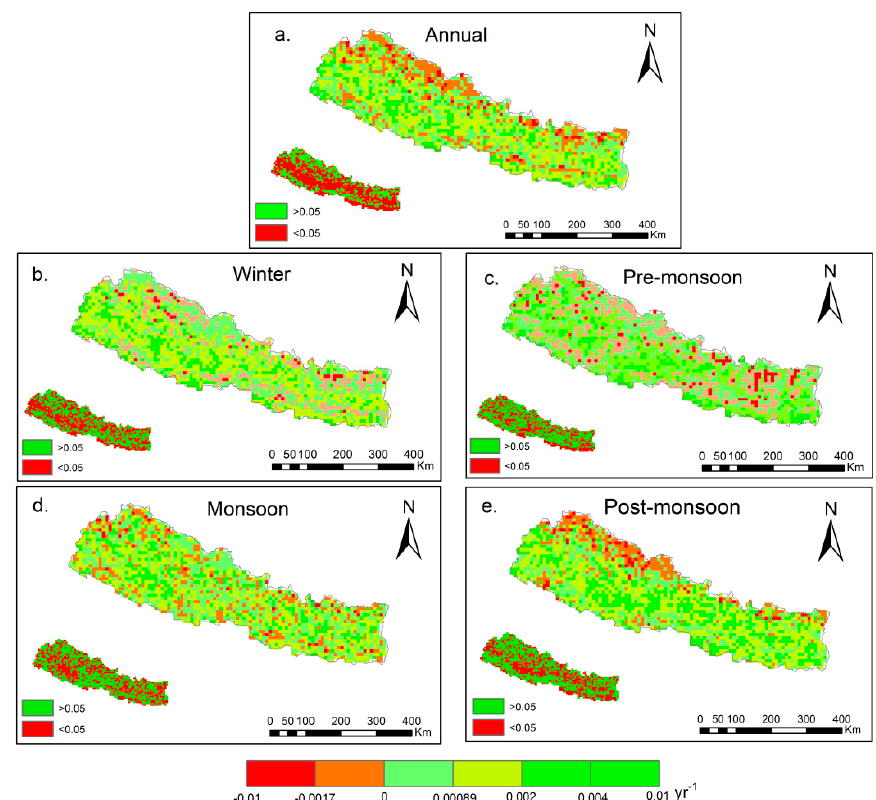
Figure 4. NDVI trends and significance of the NDVI trends at annual and seasonal time scales: ( a ) Annual NDVI; ( b ) winter season NDVI; ( c ) pre-monsoon season NDVI; ( d ) monsoon season NDVI and ( e ) post-monsoon season NDVI trend (year − 1 ) in Nepal, 1982–2015 (small maps at the bottom of annual and season slope maps show p -values of NDVI trends).